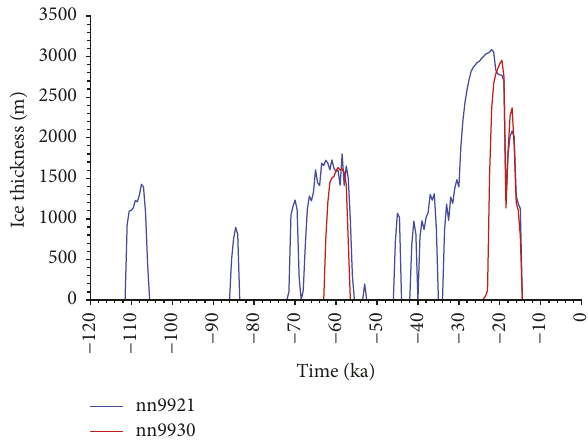
Figure 5: Ice-sheet thickness from the nn9921 and nn9930 GSM glaciation models at the DGR site. Data from Peltier